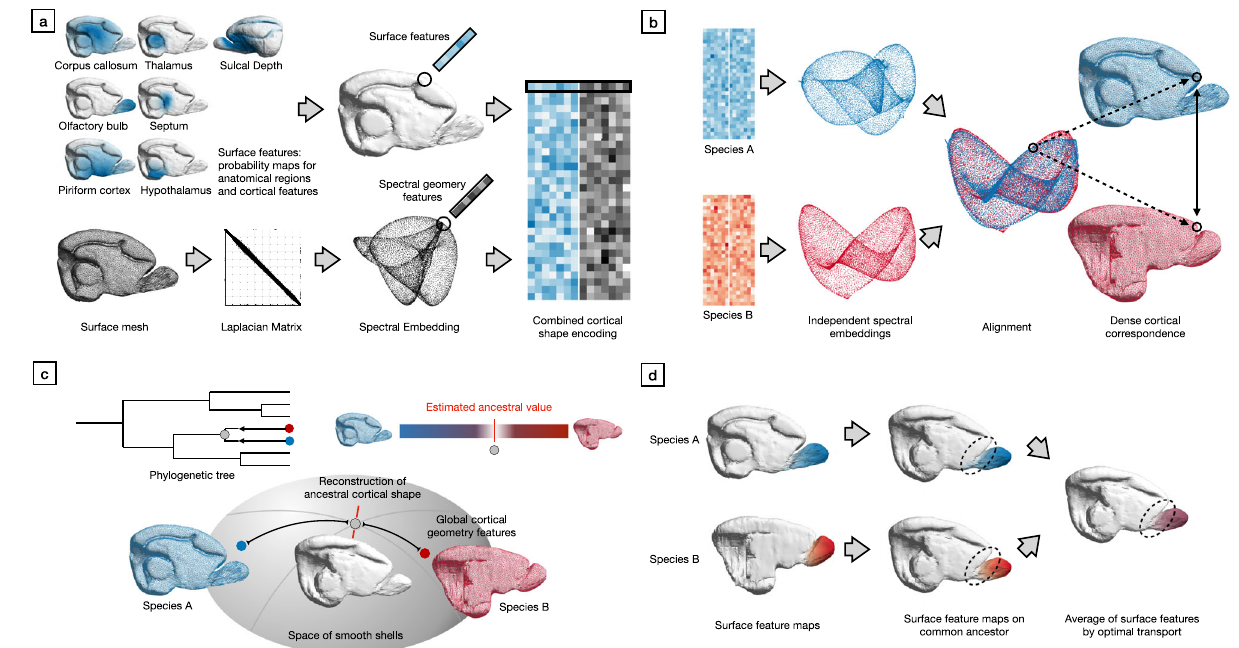
Fig. 2 | Reconstructing the cortical shape of a common ancestor. Overview of the steps required to perform shape alignment and ancestral state reconstruction betweenthesurfacemodelsofthecerebralcorticesoftwosisterspecies. a Fortwo species, anatomy and geometric features are assigned to each point on their cor- tical mesh; ( b ) after spectral embedding of both surfaces, alignment establishes